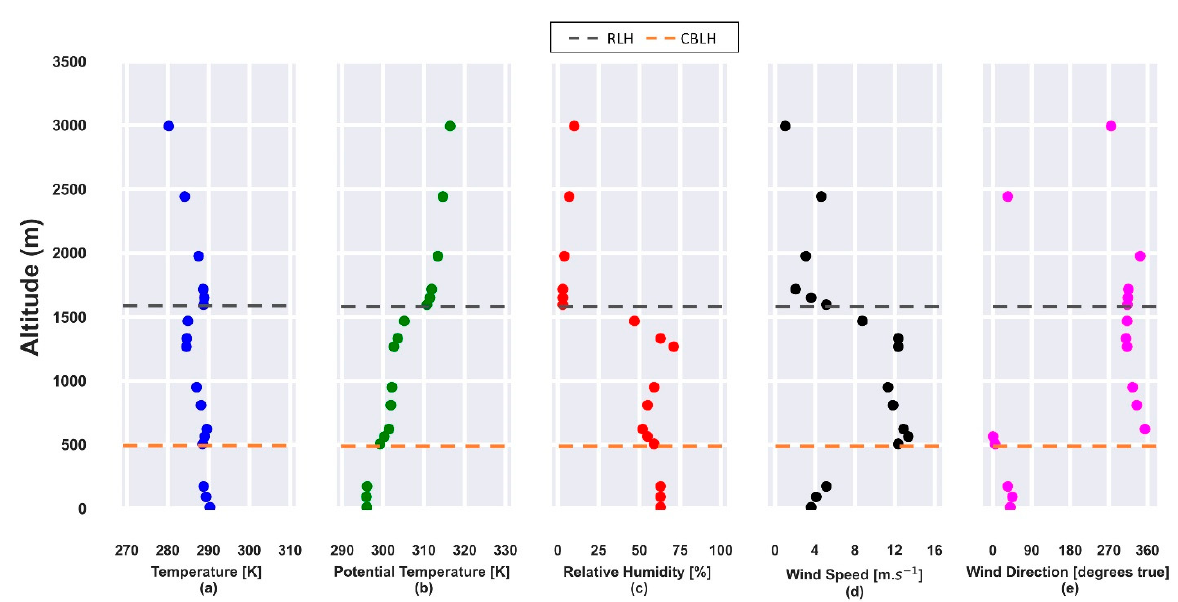
Figure 1. Atmospheric parameters obtained from radiosonde data on 22 July 2019 at 12:00 UTC. ( a ) Temperature [K]; ( b ) potential temperature [K]; ( c ) relative humidity [%]; ( d ) horizontal wind speed [m · s − 1 ]; ( e ) wind direction [degrees true]. The gray and orange dashed lines represent the residual layer height (RLH) and convective boundary layer height (CBLH), respectively.